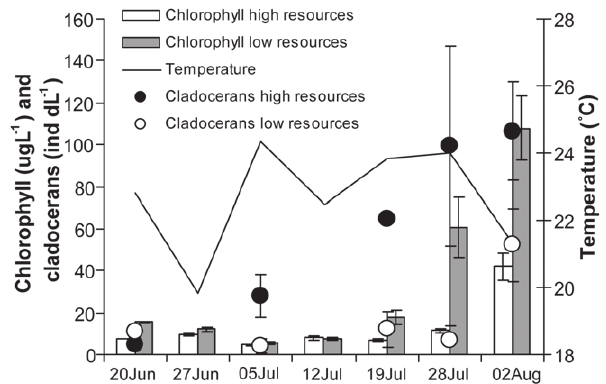
Figure 4. Mid day water temperature, chlorophyll- a content (means of all fish densities ± SE) and cladoceran abundance in fish free enclosures (mean of two replicates ± SE) in treatments with high and low algal resources from the 20 th of June to the 2 nd of August.